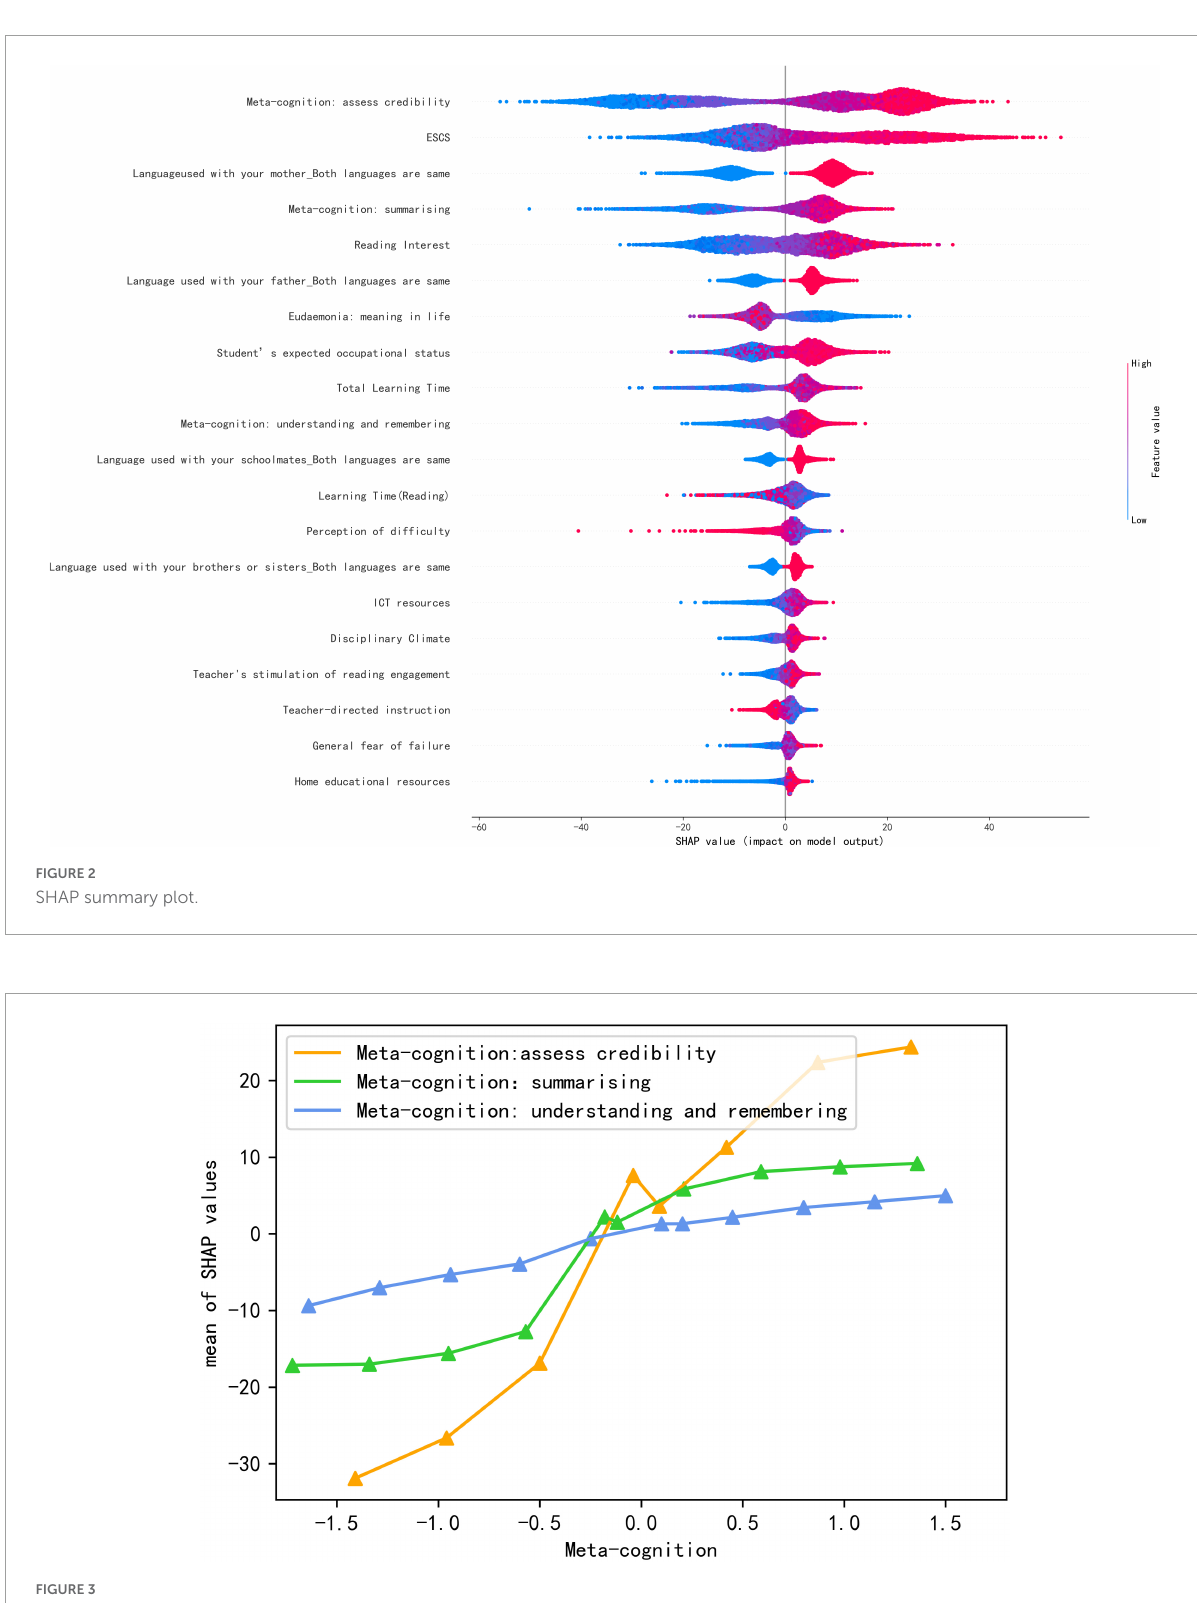
FIGURE3 The line chart of meta-cognitions and Shap